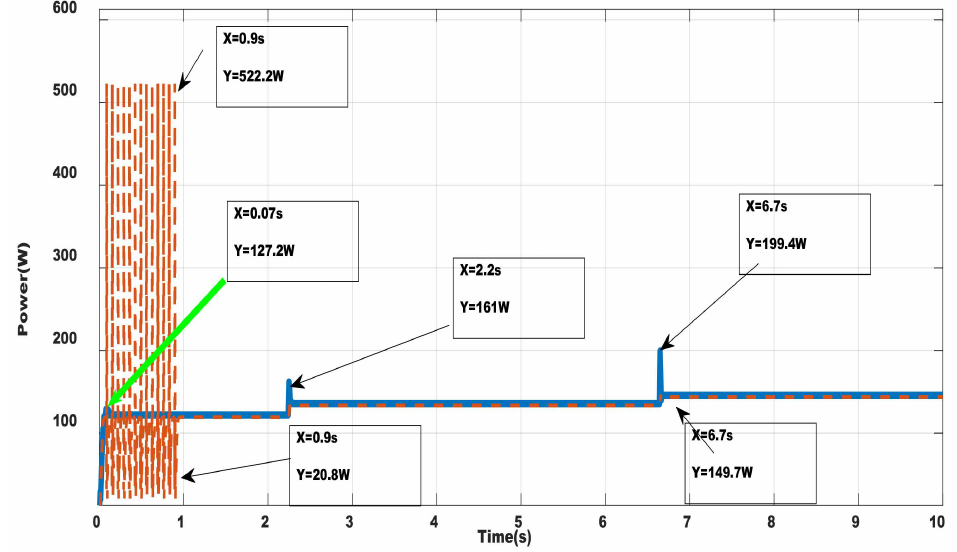
Figure 21. Power response for variable